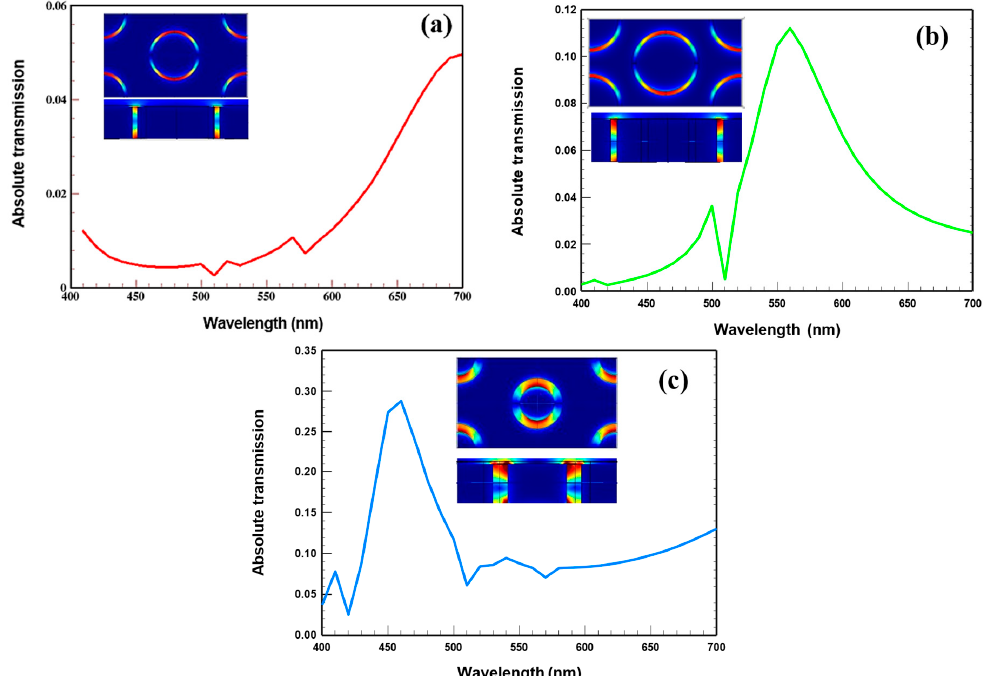
Figure 1. Simulated transmission spectrum for ( a ) red (R 1 –130 nm, R 2 –121 nm, and pitch 430 nm); ( b ) green (R 1 –130 nm, R 2 –106 nm, and pitch 430 nm); and ( c ) blue (R 1 –130 nm, R 2 –80 nm, and pitch 430 nm) plasmonic colour filters. The inset in each plot shows normalised electric field and cross-section of a coaxial hole (CH) for red, green, and blue at 700 nm, 560 nm, and 480 nm, respectively (TE 11 modes).